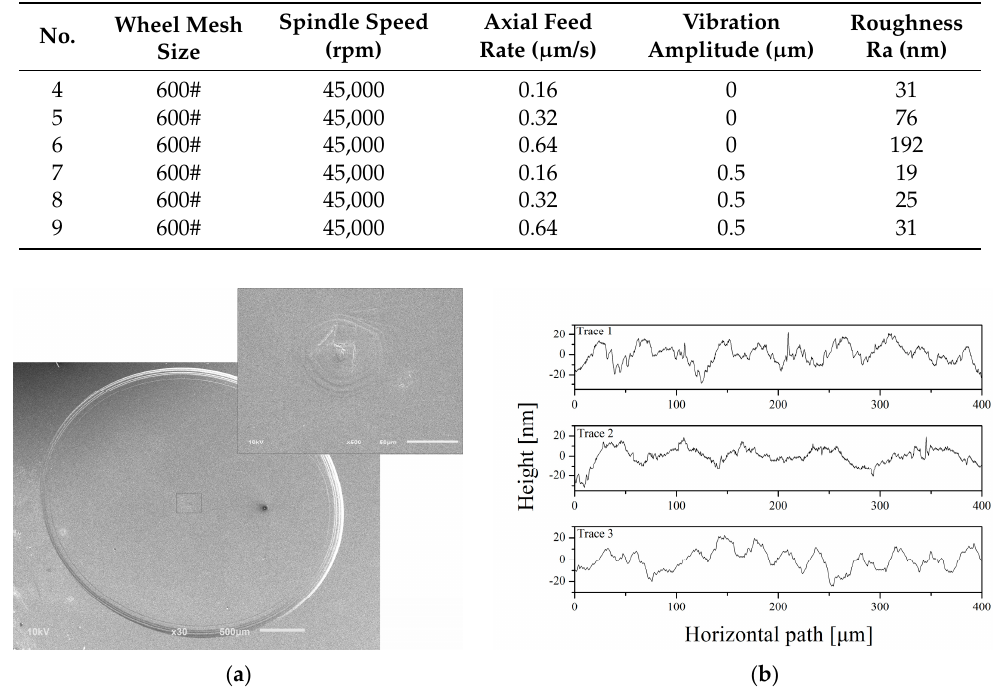
Table 1. Variations of sensor diaphragm roughness with the feed rate and amplitude of ultrasonic vibration, in the case that the spindle rotation speed is 45,000 rpm.